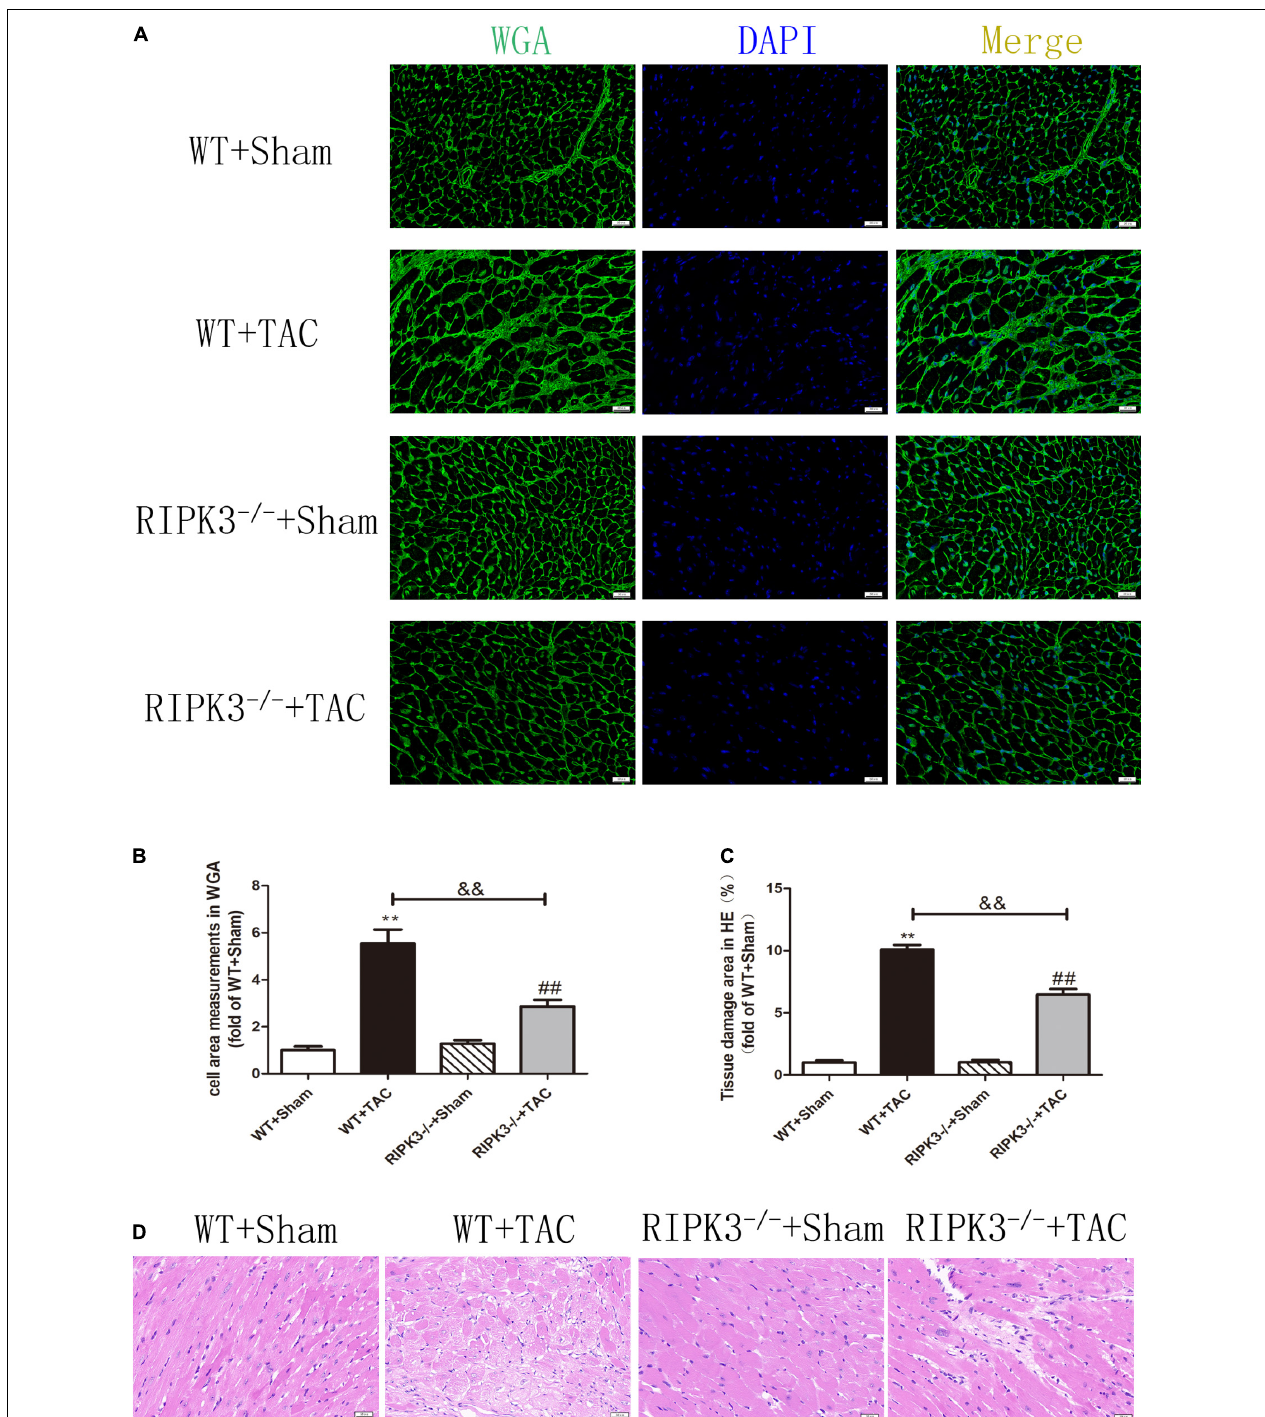
FIGURE 4 | Depletion of RIPK3 can inhibit the increase of cardiomyocyte cross-sectional area in mice with HF and improve myocardial injury. Male 8-week-old WT and RIPK3 − / − mice were treated with TAC using a 28-g needle. The control group received sham surgery. All groups of mice were given continuous feeding for 6 weeks. Hearts were then obtained for correlative testing. (A) The cross-sectional area of mouse cardiomyocytes was observed by WGA staining, bar = 50 µ m. (B) Cell area measurements in WGA. (C) Tissue damage area measurements in H&E. (D) H&E staining was used to detect the degree of myocardial injury, bar = 50 µ m. Compared with WT + sham group, ** P < 0.01; compared with RIPK3 − / − + sham group, ## P < 0.01; compared with WT + TAC group, && P < 0.01. n = 6.